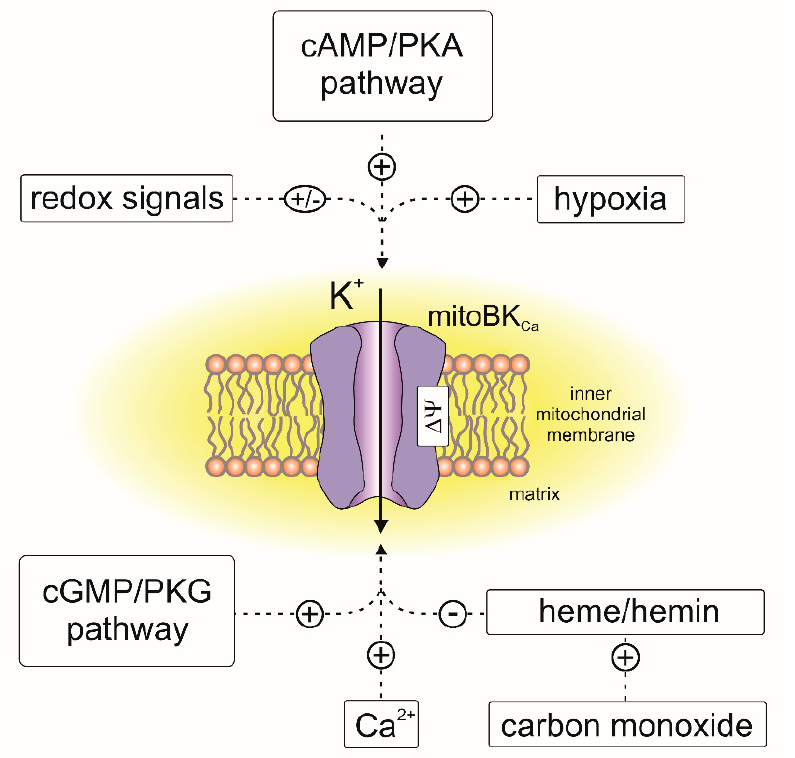
Figure 4. Regulation of the mitoBK Ca channels by endogenous factors. “+,” activation of the channel; “–,” inhibition of the channel activity. “–,” inhibition of the channel